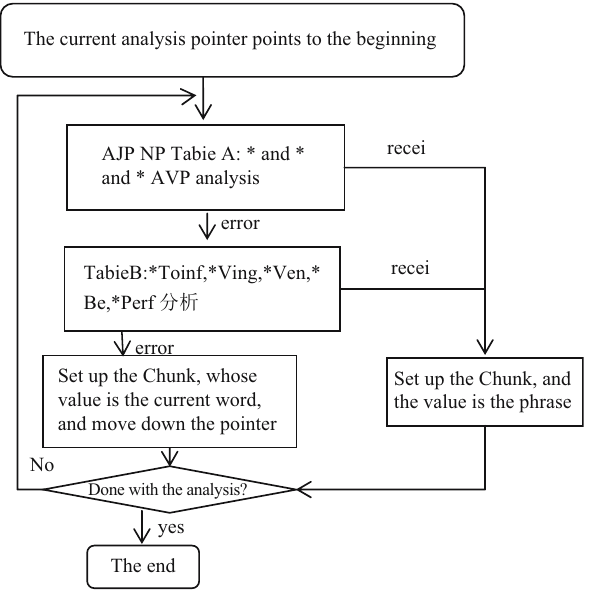
Figure 2: Shallow syntactic analyzer